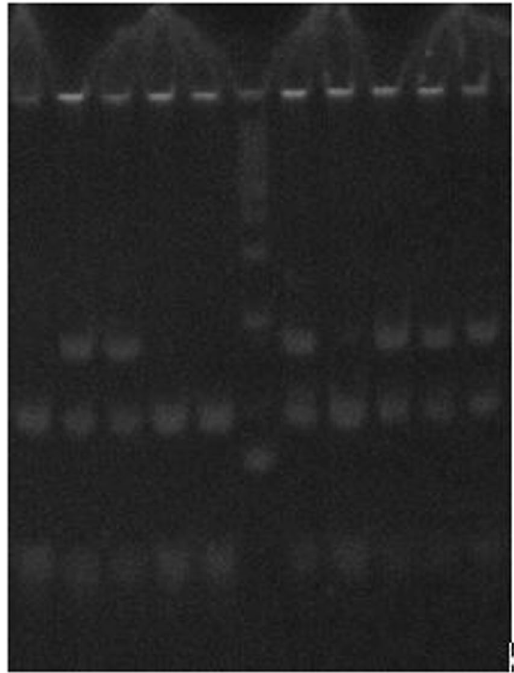
Figure 1. Electrophoresis on 6% polyacrylamide gel for -1260C/A CYP27B1 gene polymorphism (rs10877012). Bans on the gel represent the following genotypes: homozygous CC (118 bp + 60 bp), heterozygous CA (179 bp + 118 bp + 60 bp), homozygous AA (179 bp). The visualization was conducted with the use of ethidium bromide. The photography was made using PhotoDoc-IT Imaging System (Ultra-Violet Products Ltd,